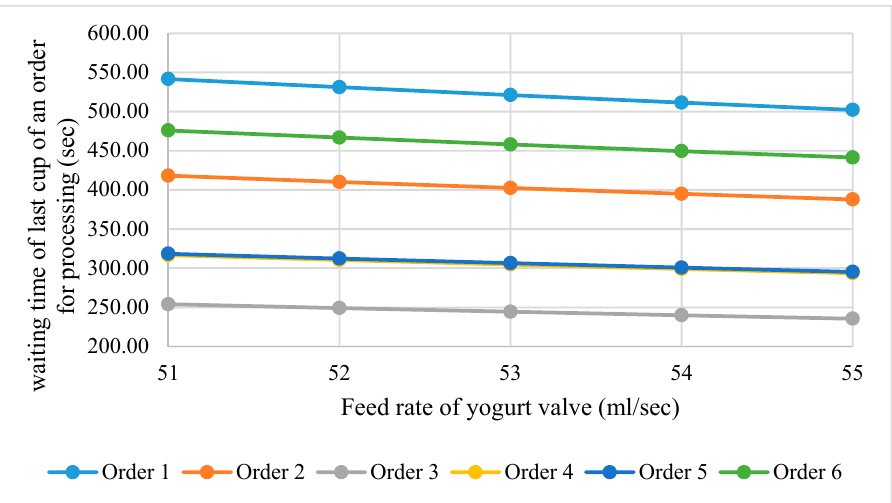
Figure 6. The effect of feed rate of yogurt valve on the waiting time of last cup of an order for processing.